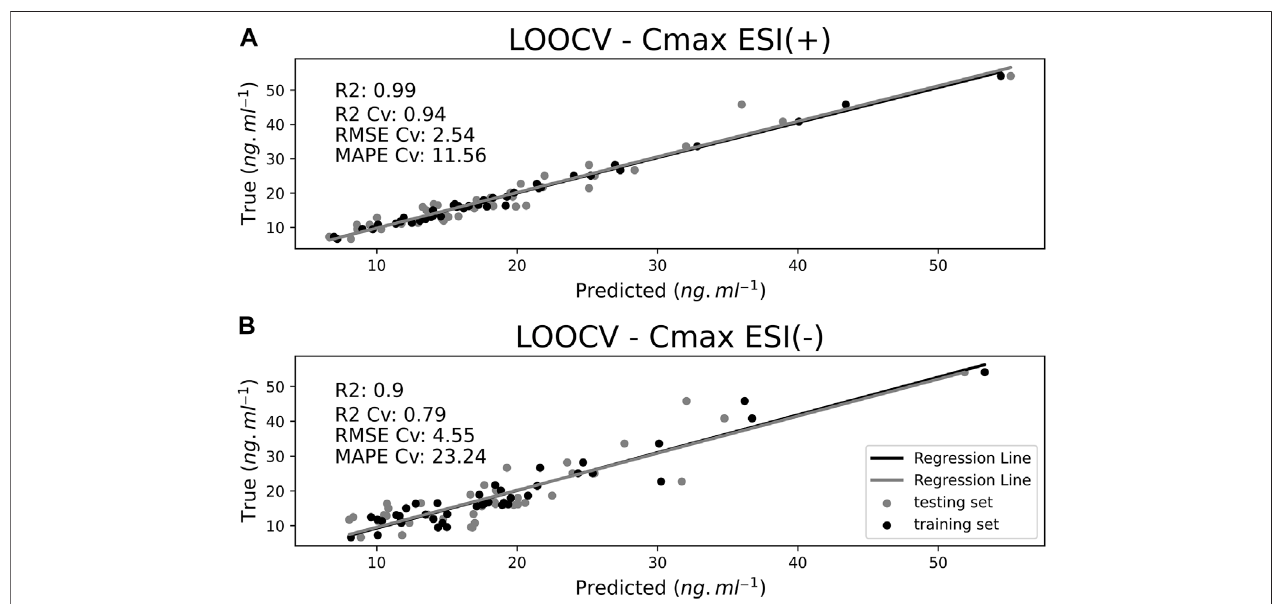
FIGURE7| Maximumplasmadrugconcentration( C max )predictionsforESI(+) (A) andESI( − ) (B) datasetscomparingtrainingsamples(blackdots)withleave-one- out cross-validation (LOOCv) testing samples (gray dots). X -axis represents model-predicted values and Y -axis the true values.